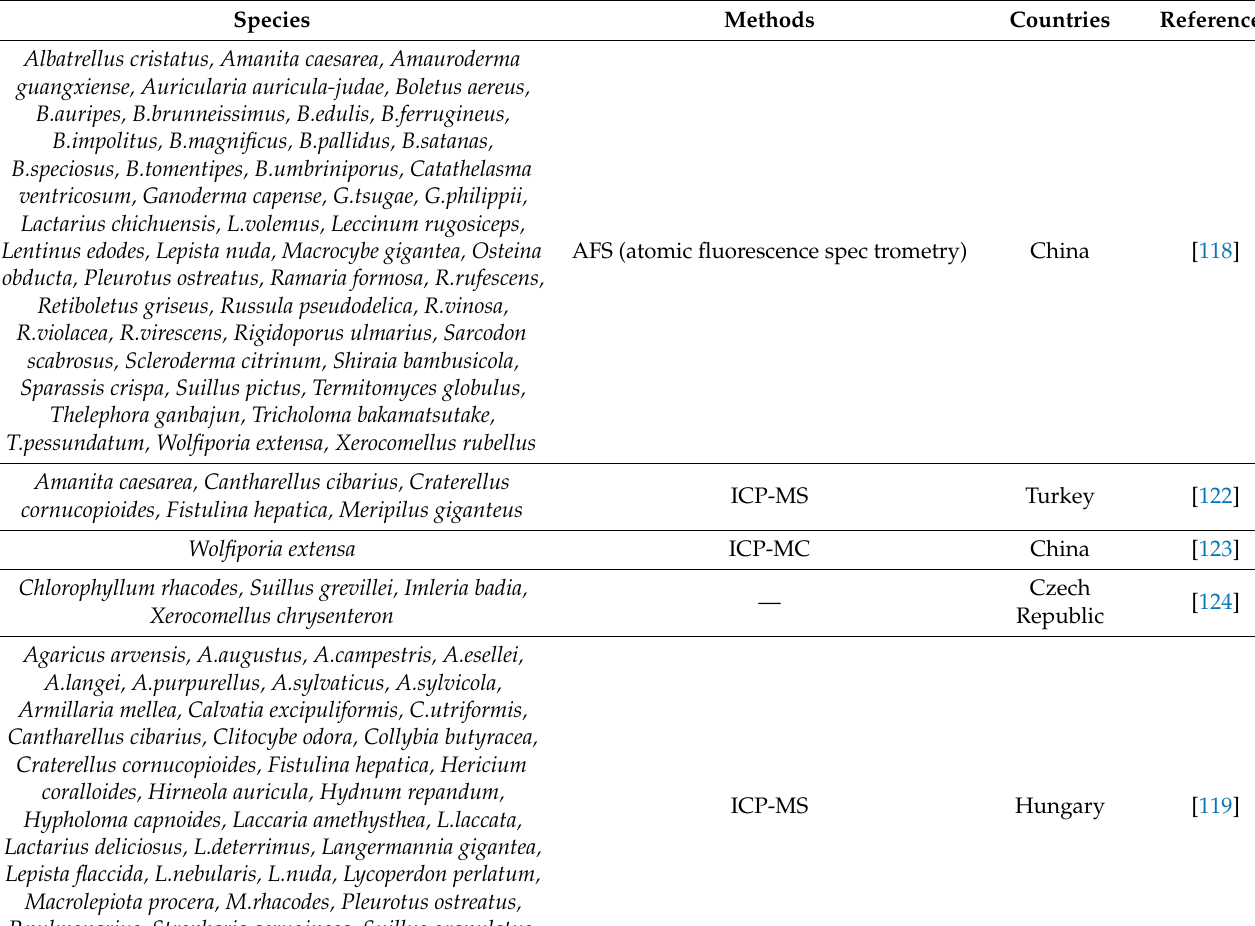
Table 10. Species, methods for determination of arsenic and countries in the